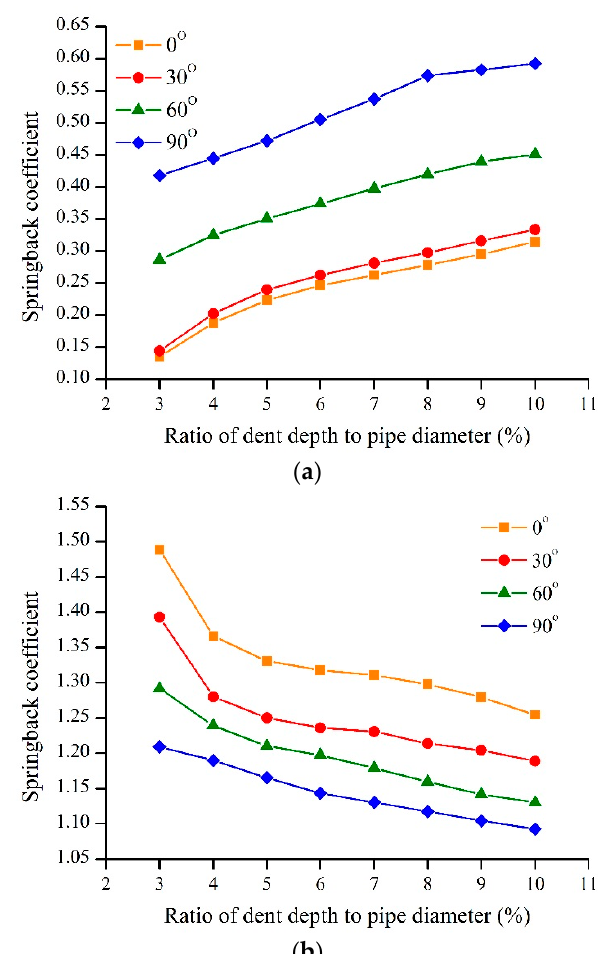
Figure 9. Dent depth and springback coefficient with variation of the dent locations during denting: ( a ) pressurization; ( b ) de-pressurization.